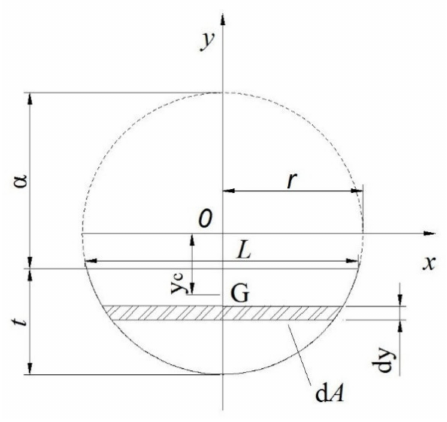
Figure 13. Schematic diagram of the pruned branch.